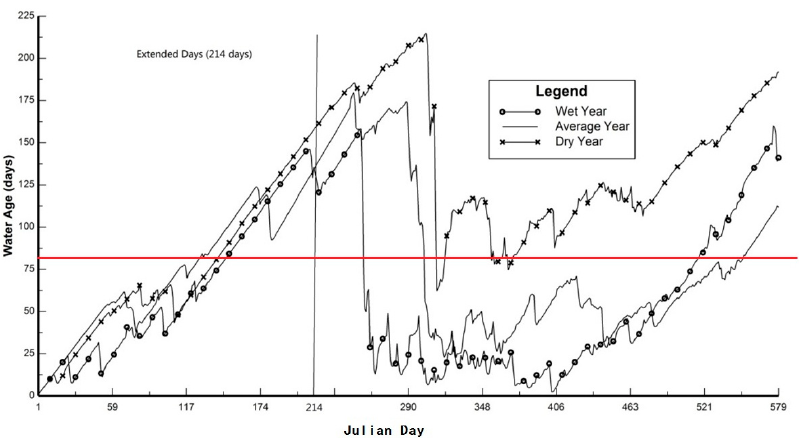
Figure 5. The simulated daily water age in the years of 1992, 1988, and 2004 in CTR.